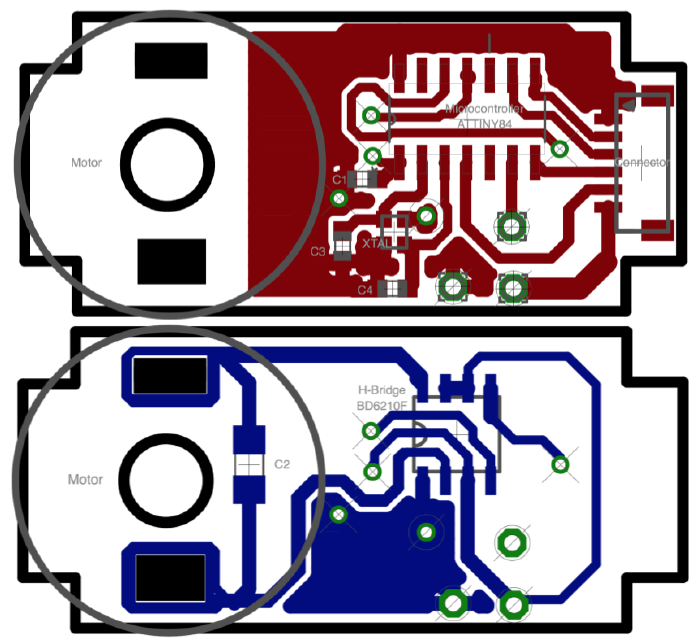
Figure 7. Control circuit board design: ( top ) the top layer of the PCB; and ( bottom ) the bottom layer.